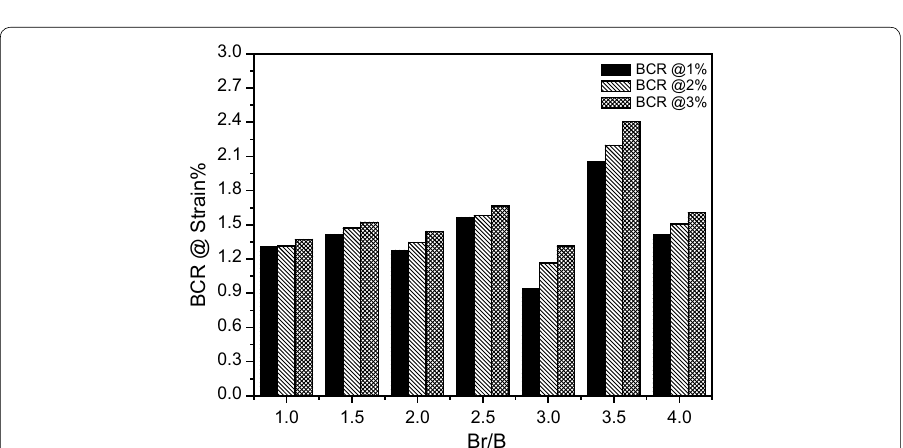
Fig. 12 BCR of reinforced soil for 1, 2 and 3% strain for 75 mm square footing with size of reinforcement